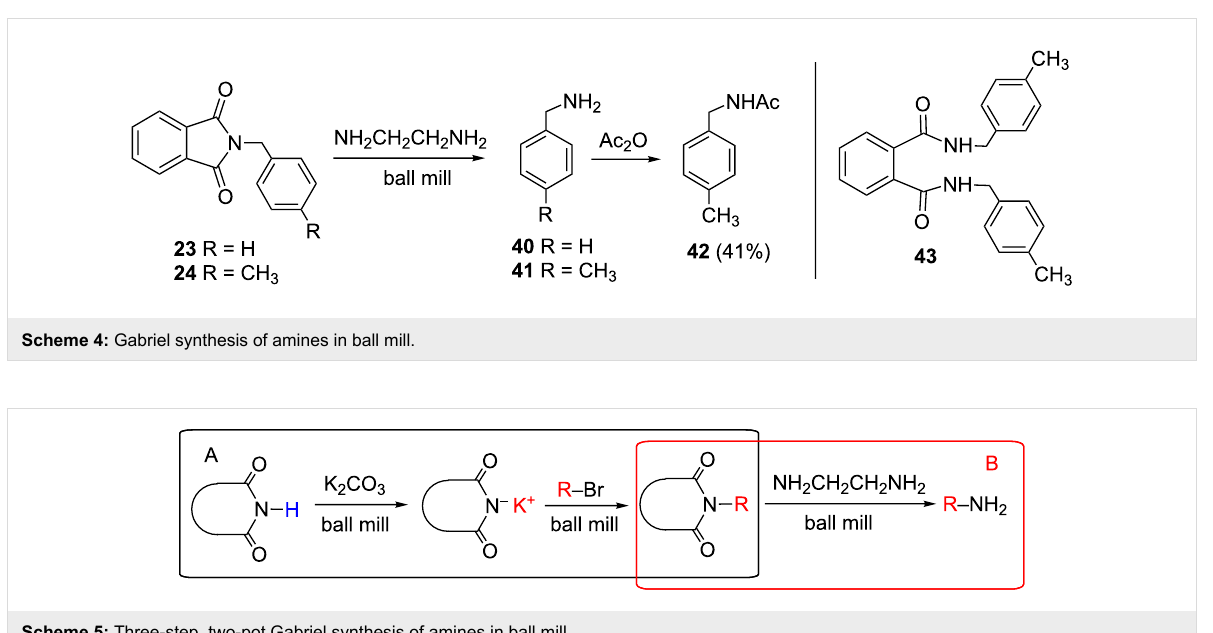
Scheme 5: Three-step, two-pot Gabriel synthesis of amines in ball